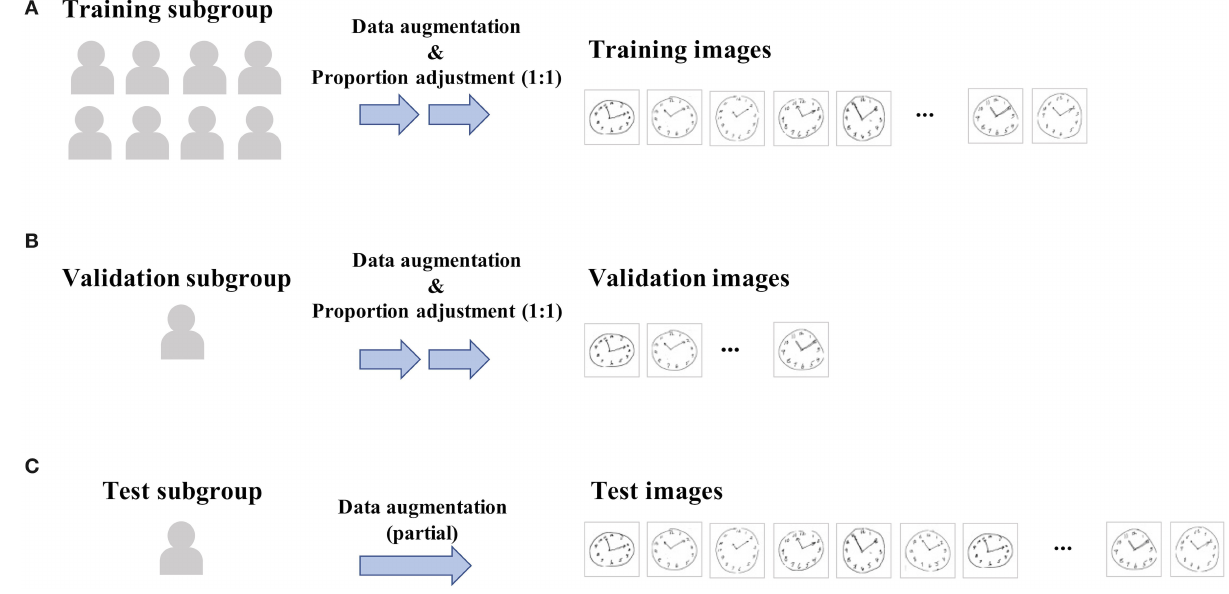
FIGURE 2 | Data workflow for training and validating. All eligible cases were randomly split into three subgroups [i.e., training (A) , validation (B) , or test (C) subgroup] in an approximate 8:1:1 ratio, and then, the CDT image samples derived from these cases were to belong to the same subgroup as of cases. Data splitting was conducted so as to make the proportion of positive samples included in each subgroup being almost equal. Then, for training and validation subgroups, proportions in the positive vs. negative samples were further adjusted to be 1:1 within each subgroup by randomly downsampling negative samples, since the original sample data are highly imbalanced (e.g., proportion of cases with dementia is <